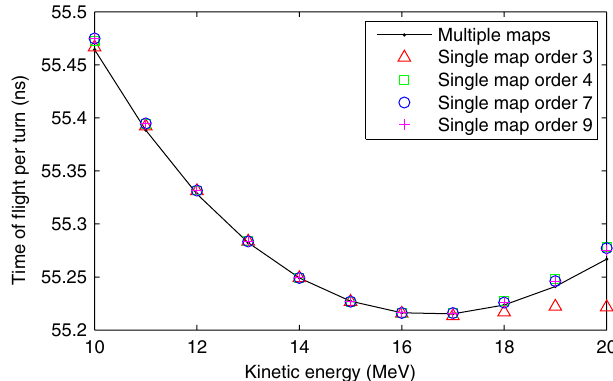
FIG. 8. Time of flight for various energies computed with a set of transfer maps at different reference energies (line), and with a single transfer map with different energy deviations (triangles, squares, circles, crosses for orders 3, 4, 7, and 9, respectively). We see good agreement for the maps truncated at 4th order or